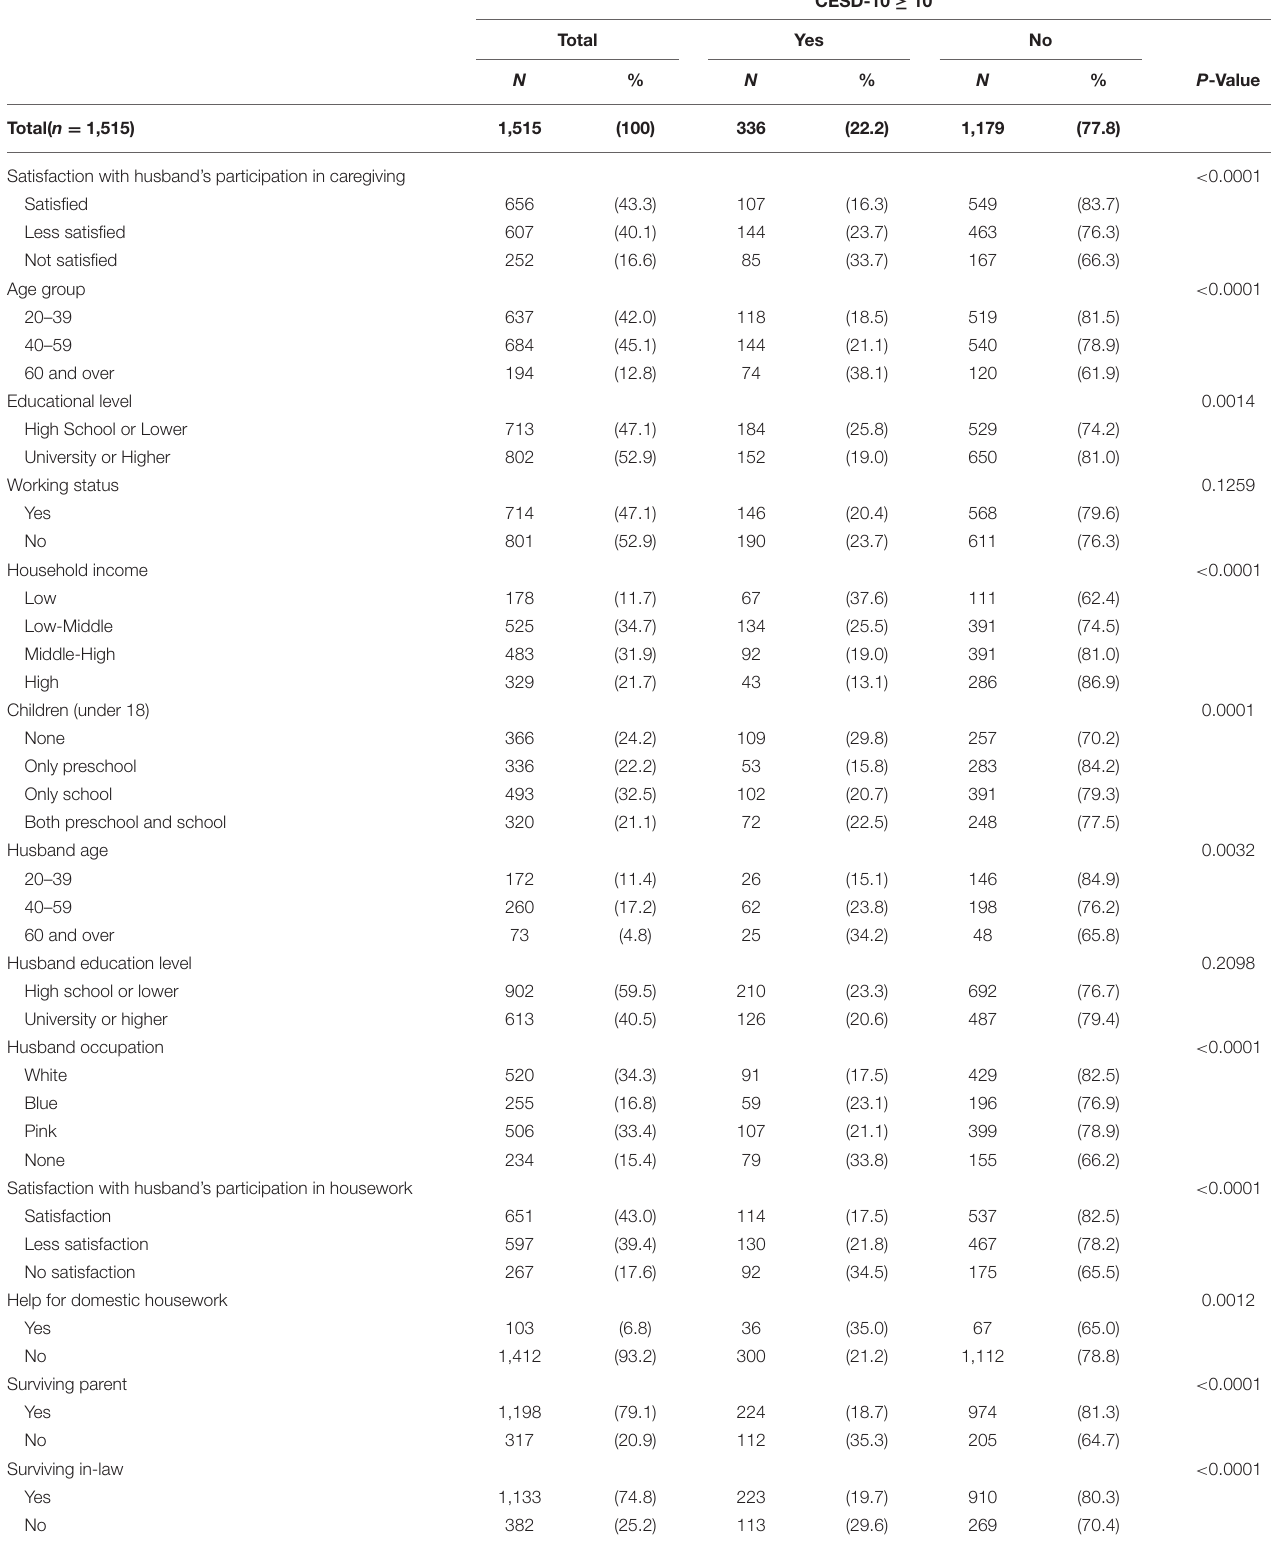
TABLE 1 | General characteristics of study